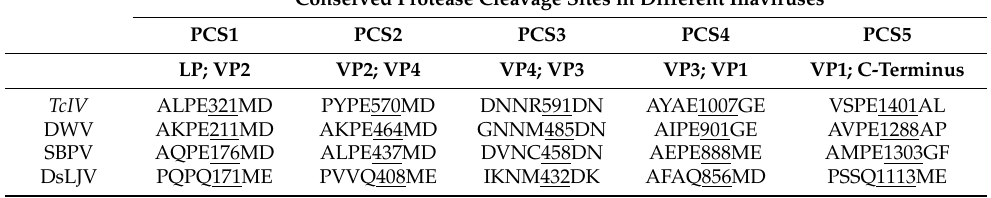
Table 1. Comparison of putative capsid proteins cleavage sites in different iflaviruses ( TcIV : T.